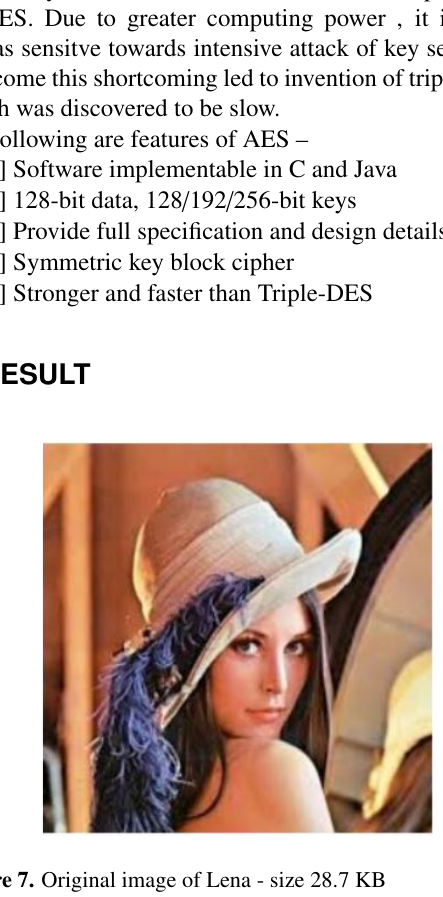
Figure 7. Original image of Lena - size 28.7 KB